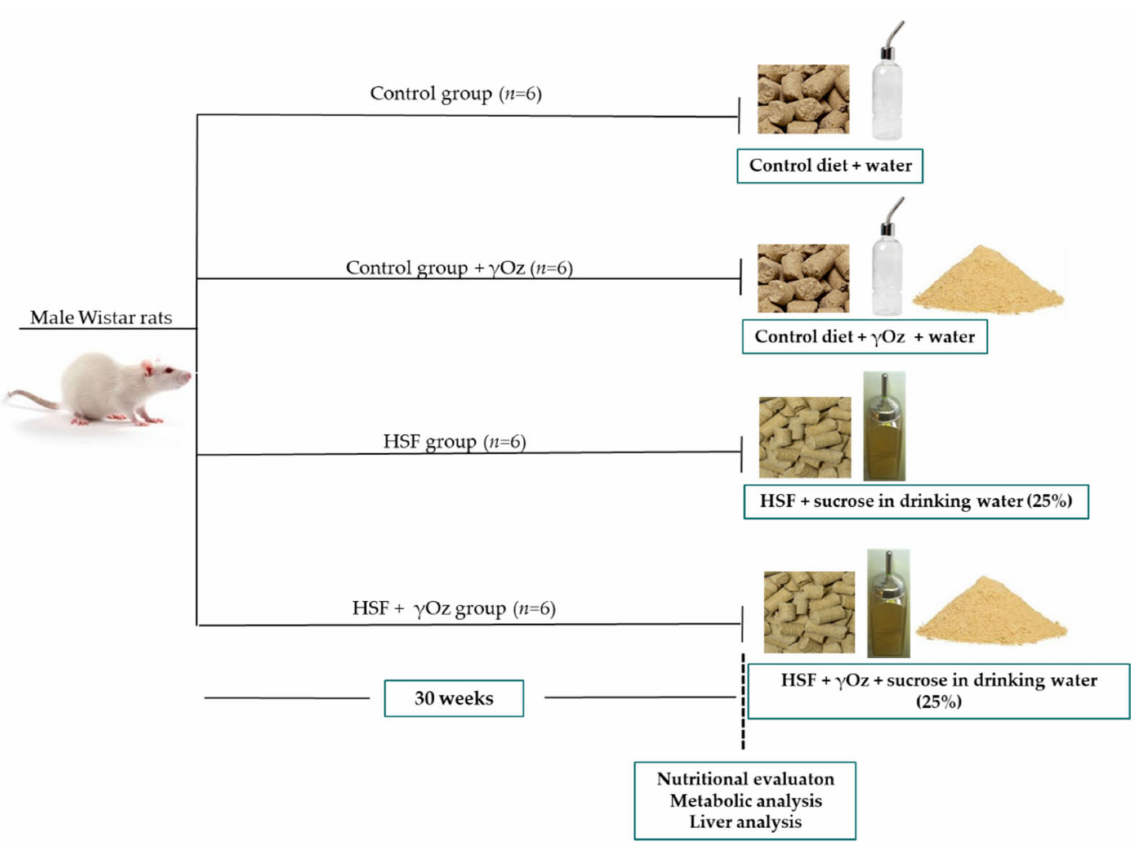
Figure 1. Experimental protocol. Animals were fed during 30 weeks. Control groups received control diet plus water; HSF groups received high sugar/fat diet plus sucrose in drinking water (25%). Nutritional evaluation and metabolic and liver analysis occurred at the end of 30 weeks. HSF—high sugar/fat diet; γ